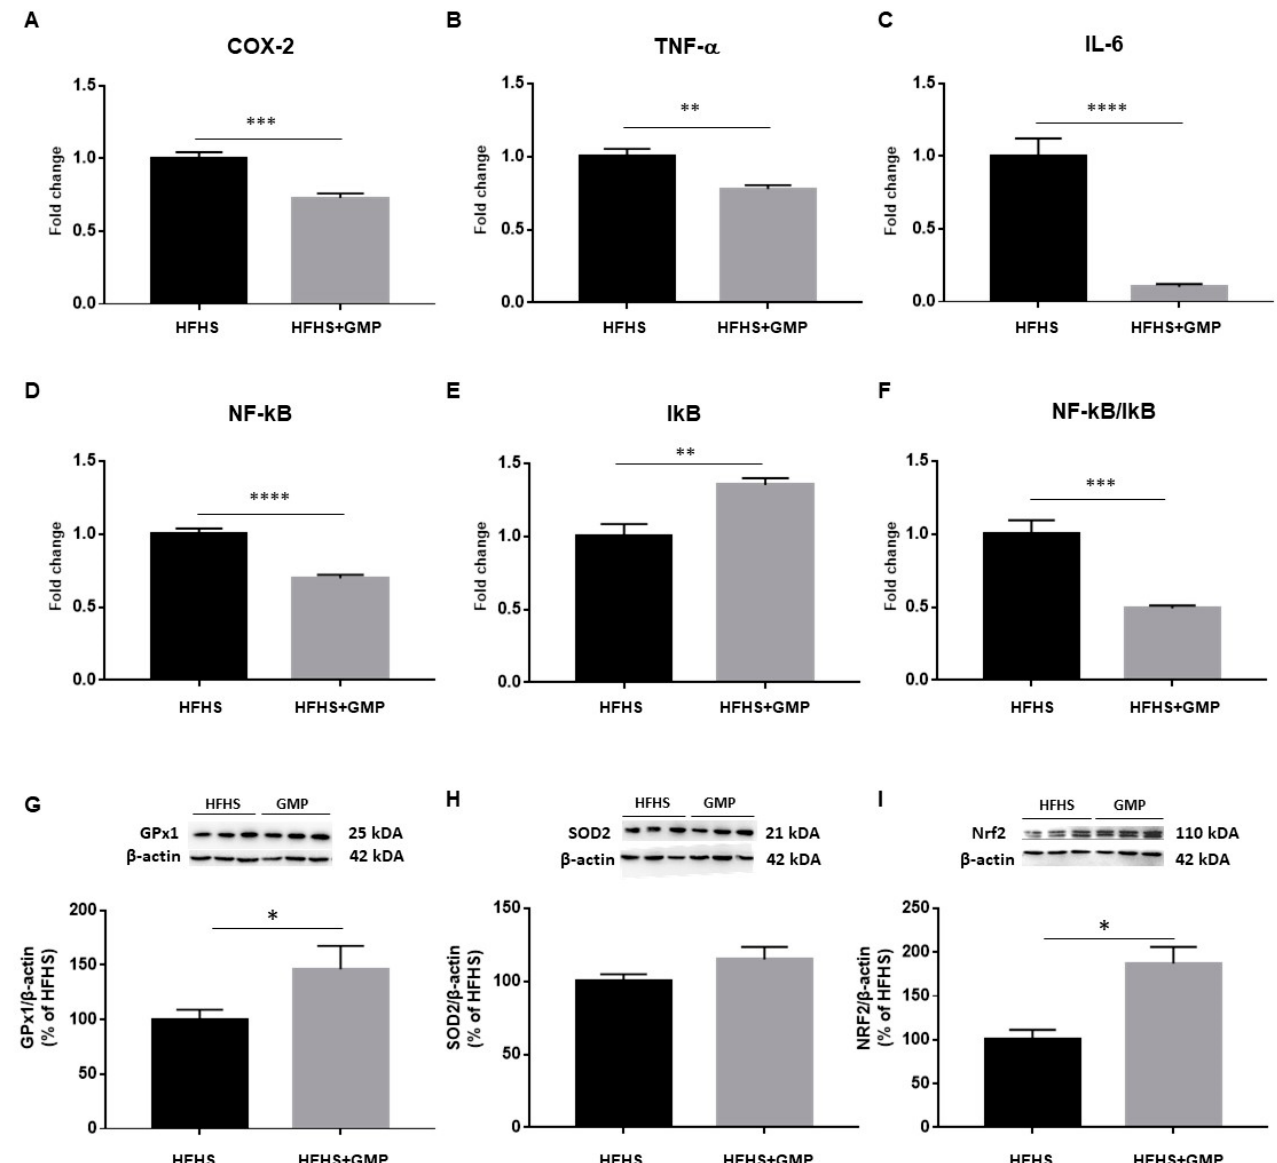
Figure 3. Anti-inflammatory and antioxidant effects of GMP in the liver of HFHS-treated mice. The gene expression of ( A ) cyclooxygenase-2 (COX-2), ( B ) tumor necrosis factor alpha (TNF- α ), ( C ) interlukin-6 (IL-6), ( D ) nuclear factor-kappa B (NF- κ B) and ( E ) inhibitor of kappa B (I κ B) was determined by RT-qPCR as described in Section 2. ( F ) The NF- κ B/I κ B ratio was then calculated. The protein mass of antioxidant defense biomarkers: ( G ) glutathione peroxidase1 (GPx1), ( H ) superoxide dismutase 2 (SOD2) and the transcription factor ( I ) nuclear factor erythroid 2 related factor 2 (NRF2) was evaluated by Western blot as described in Material & Method section. Results represent the mean of n = 6–8 mice/group. * p < 0.05, ** p < 0.01, *** p < 0.001, **** p < 0.0001 vs. HFHS mice.